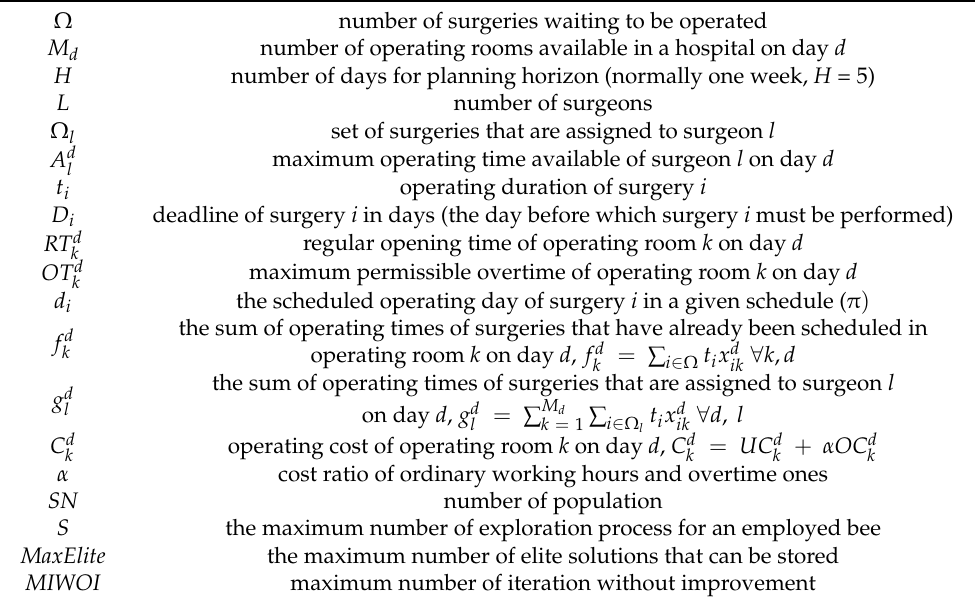
Table 1. Notations used in this